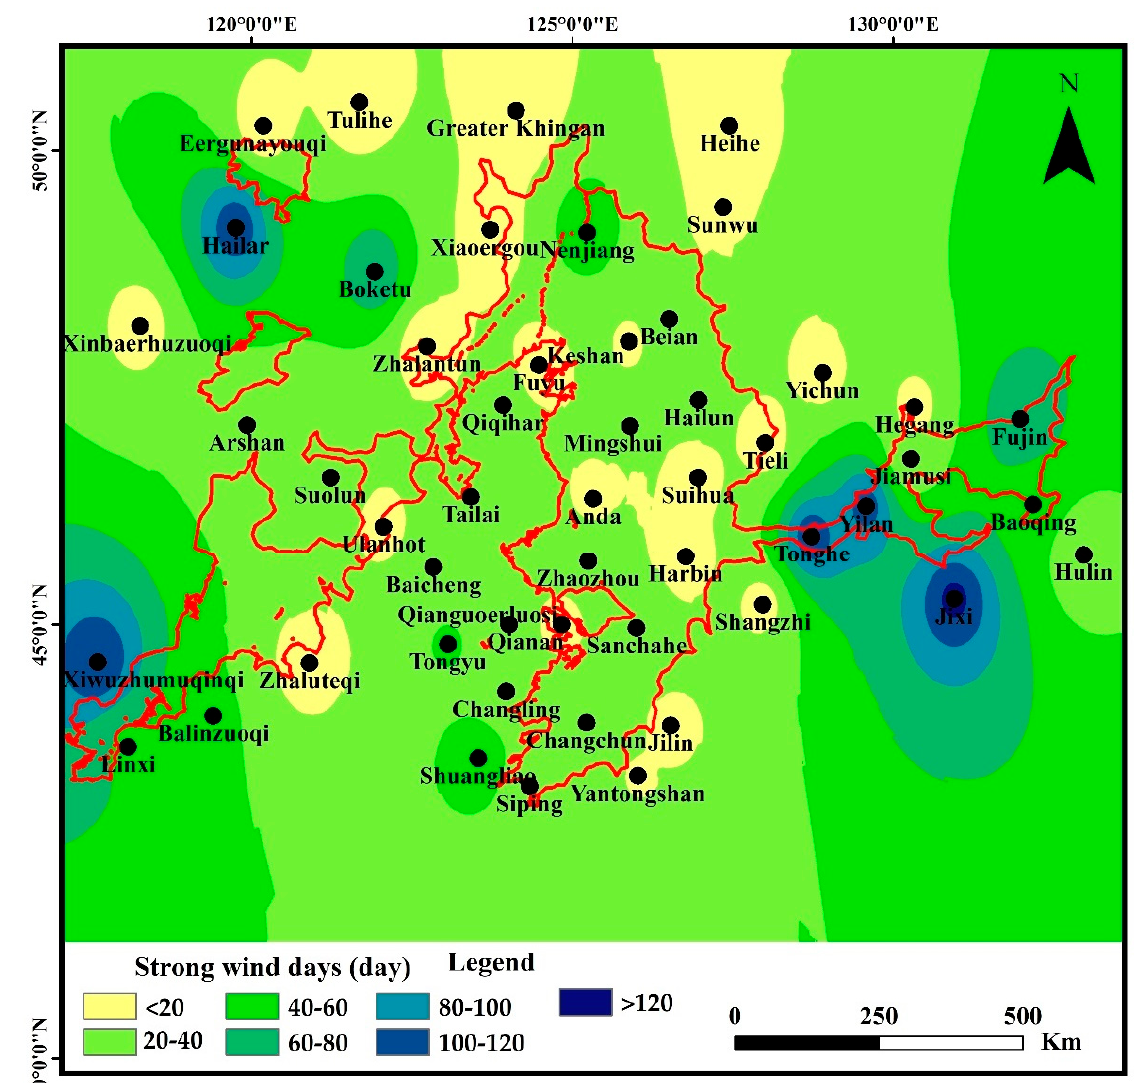
Figure 9. Spatial distribution of strong wind days in the water erosion area of the typical black soil region.